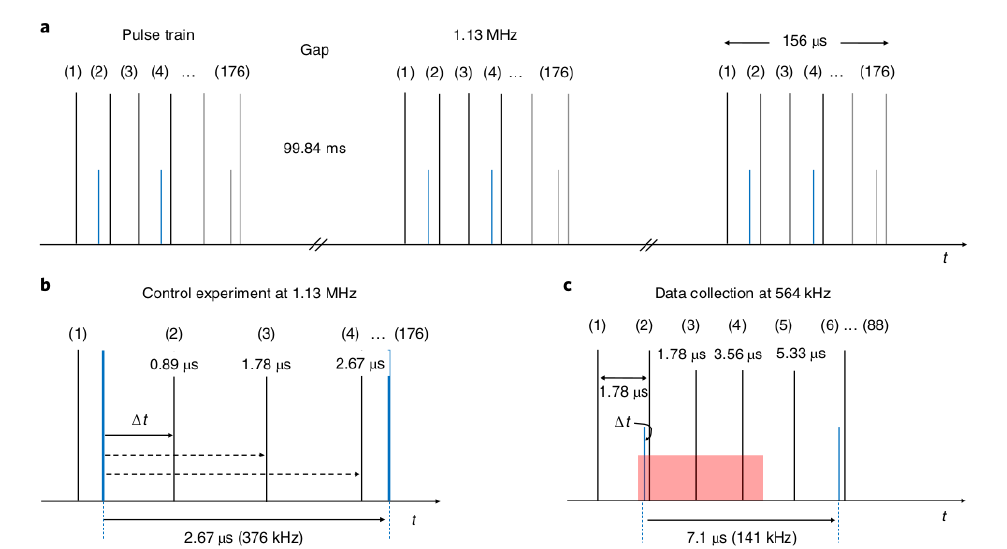
Figure 11. Pump–probe timing schematic. Black lines indicate X-ray pulse timing. ( a ) A schema showing that there are 176 X-ray pulses in each train at 1.1 MHz, with a 99 ms gap between trains. Blue lines indicate the laser probe timing relative to the X-ray probe arrival. ( b ) The ∆ t schema at 1.1 MHz. ( c ) The 0.5 MHz timing schema. The red box indicates that the length of the pump laser duration overlaps with three X-ray pulses before leaving the 5.33 us X-ray pulse unilluminated. Figure originally published in Nat. Methods [64].